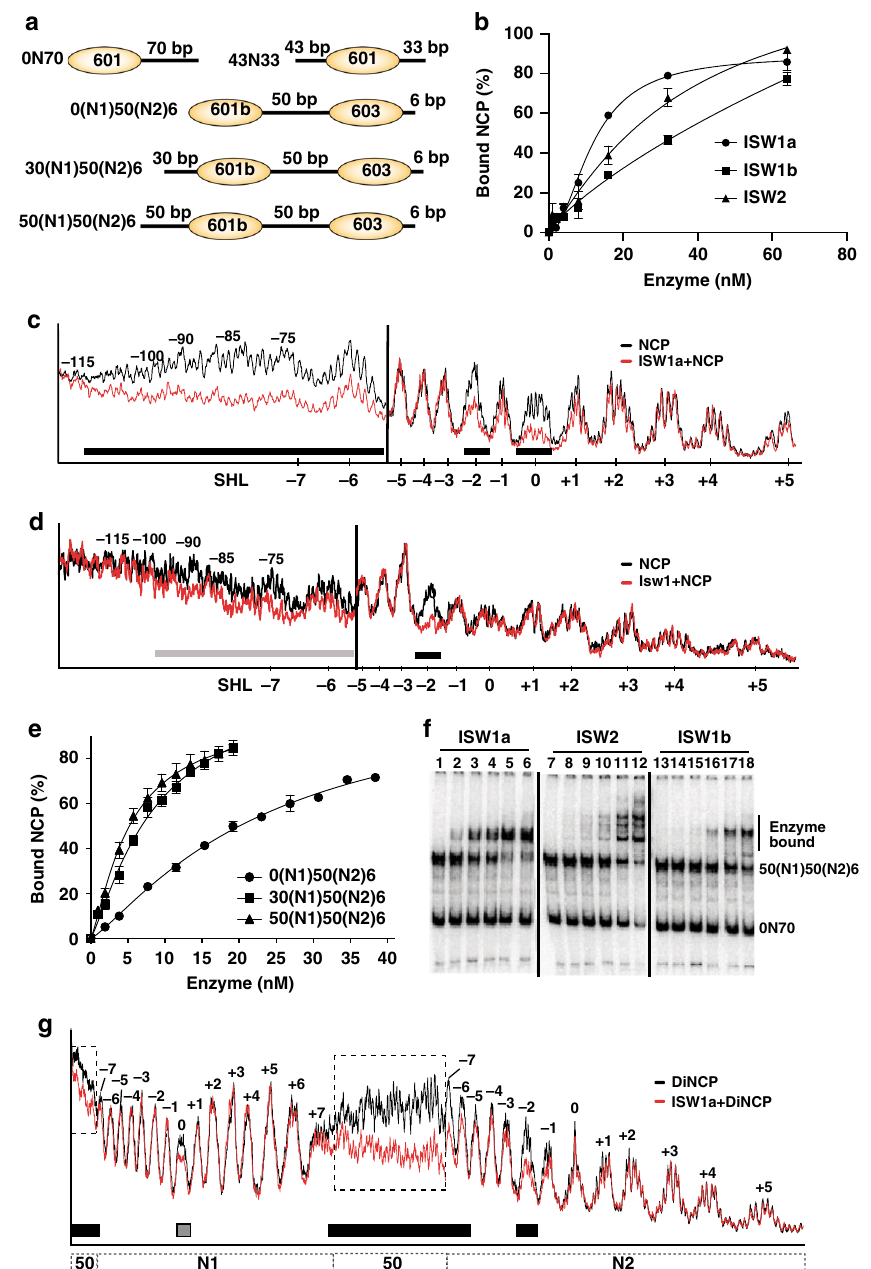
Fig. 1 ISW1a has a higher af fi nity for dinucleosomes than mononucleosomes unlike ISW1b and ISW2. a Schematic shows the mono- and di-nucleosome substrates (light orange oval) used in this study. There are generally two types of mononucleosomes using the 601 Widom sequence with fl anking DNA primarily on one side or approximately equivalent lengths of fl anking DNA on both sides. There are three different dinucleosomal substrates that have in common 50 bp of DNA separating nucleosomes (NCP) assembled onto 601b and 603 nucleosome positioning sequences with 6 bp of DNA fl anking the other side of the 603 nucleosome. The substrates varied based on the DNA length fl anking the other side of the 601b nucleosome (0, 30, and 50 bp). b The af fi nities of ISW1a (closed circle), ISW1b (closed square) and ISW2 (closed triangles) for 0N70 mononucleosomes was measured by Electrophoretic Mobility Shift Assay (EMSA) using 20 nM nucleosomes and remodeler concentrations up to 60 nM. c , d The DNA interactions of ( c ) ISW1a and ( d ) Isw1 bound to 0N70 nucleosomes were mapped by DNA footprinting with hydroxyl radicals. The footprint with free nucleosomes is shown in black and with remodeler bound in red. Black and gray bars at the bottom of the trace marks the regions of strong and weak interactions. e The extent of 0(N1)50(N2)6 (closed circle), 30(N1)50(N2)6 (closed square) and 50(N1)50(N2)6 dinucleosomes (closed triangle) bound by wild-type ISW1a were plotted versus enzyme concentration. f The potential preference for binding 50(N1)50(N2)6 dinucleosomes versus 0N70 mononucleosomes with ISW1a, ISW2 or ISW1b was tested by EMSA using 15 nM each of mono- and di-nucleosomes and remodeler concentrations up to 20 – 25 nM. g DNA footprinting of ISW1a bound to 50(N1)50(N2)6 dinucleosomes was done similar to that described in ( c , d ). DNA footprinting experiments had a minimum of 2 – 3 replicates, all with similar results as those shown. All EMSA experiments were from n = 3 independent experiments and for those graphed the error bars are presented as mean values + / − SD. Source data are provided as a Source Data fi